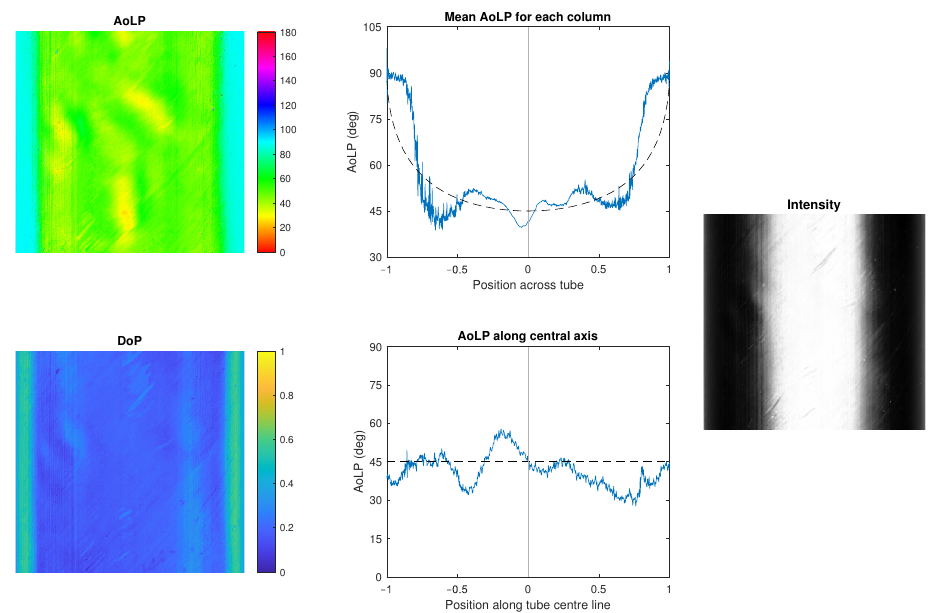
Figure 24. Recovered data for the UD cured tube under dome illumination in a similar format to the case of Figure